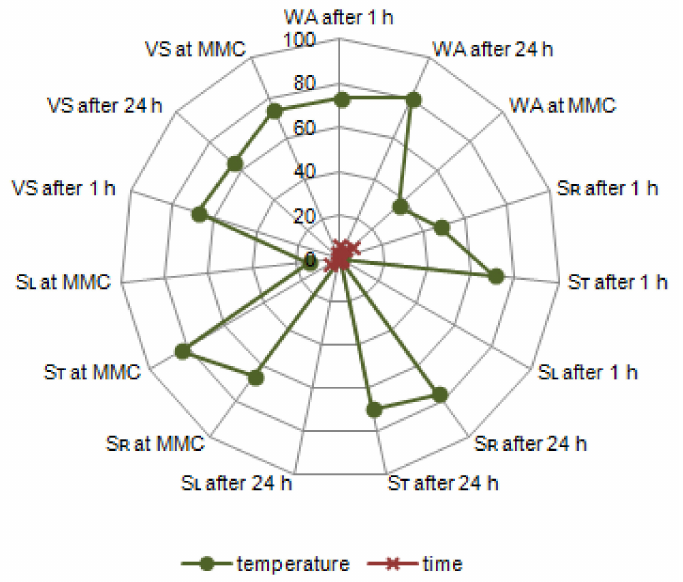
Figure 7. The percentual influence of temperature and modification time on water absorption (WA), linear swelling in the radial (S R ), tangential (S T ), longitudinal (S L ) directions and volumetric swelling (VS) of black poplar thermally modified in a nitrogen